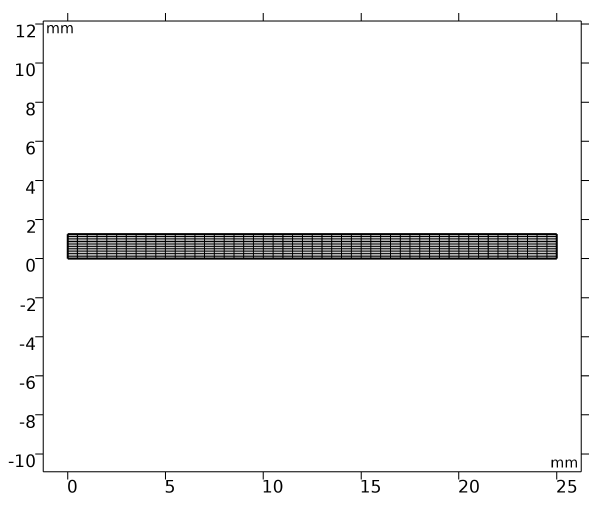
Figure 4. Example mesh used for numerical simulation.